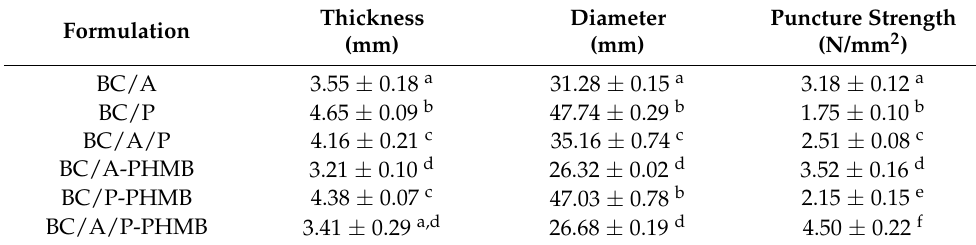
Table 2. Thickness, diameter, and puncture strength of hydrogels containing